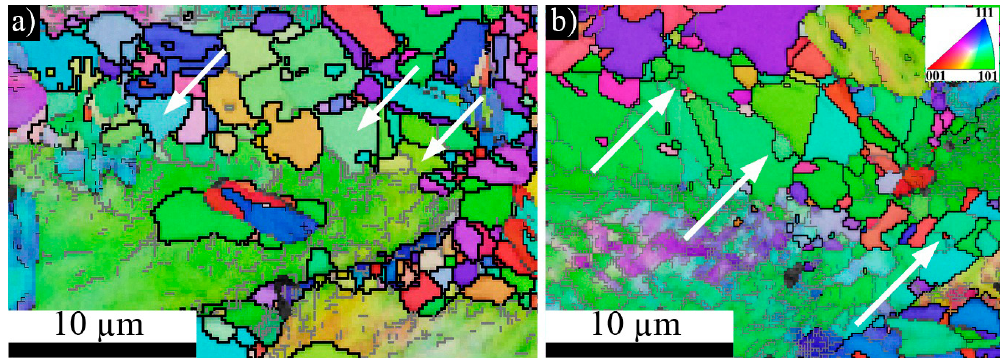
Figure 7. Two examples ( a , b ) of the formation of medium-sized grains from shear-reversed DIM by gradual evolution of subgrains in 750-0.1-32CR (shown by arrows). EBSD inverse pole figures (IPF) overlap with grain boundary maps. High-angle grain boundaries are black; low-angle grain boundaries gray.